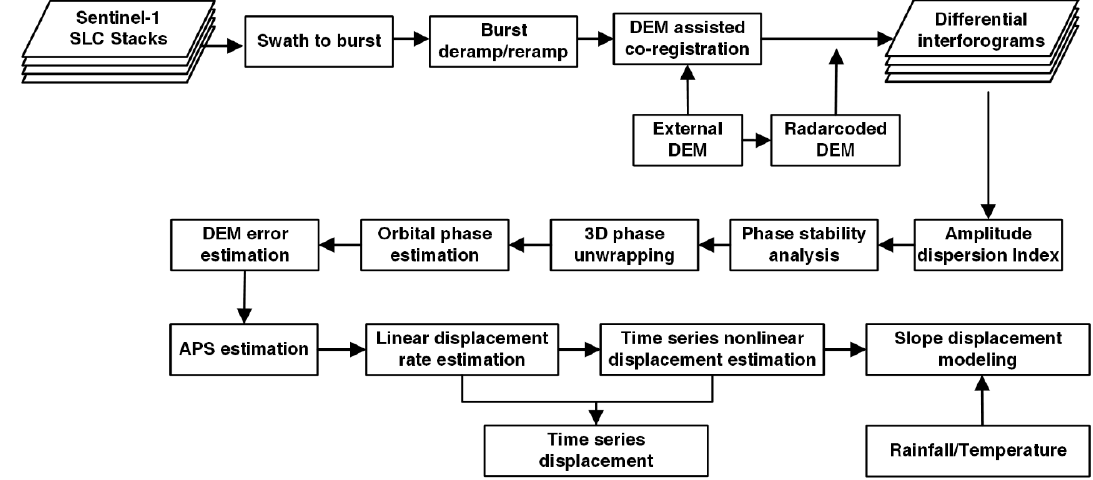
Figure 3. Workflow of time-series Interferometry Synthetic Aperture Radar (InSAR) analysis and displacement modeling in this